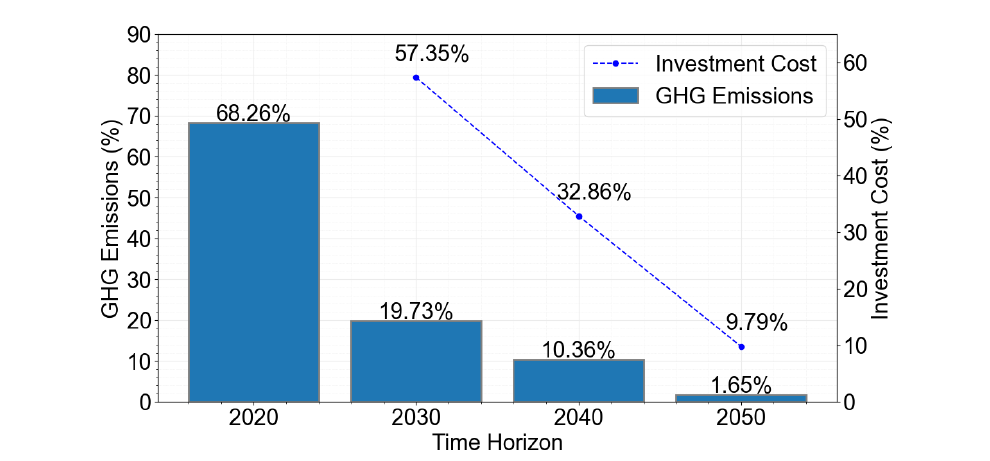
Figure 10. Alternative 2—Comparison between emissions and the investment cost for the residential sector.